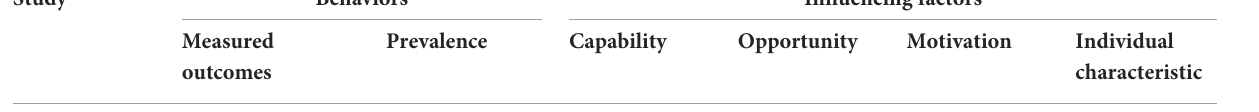
TABLE 5 The public’s antibiotic adherence behaviors for URTIs and its influencing